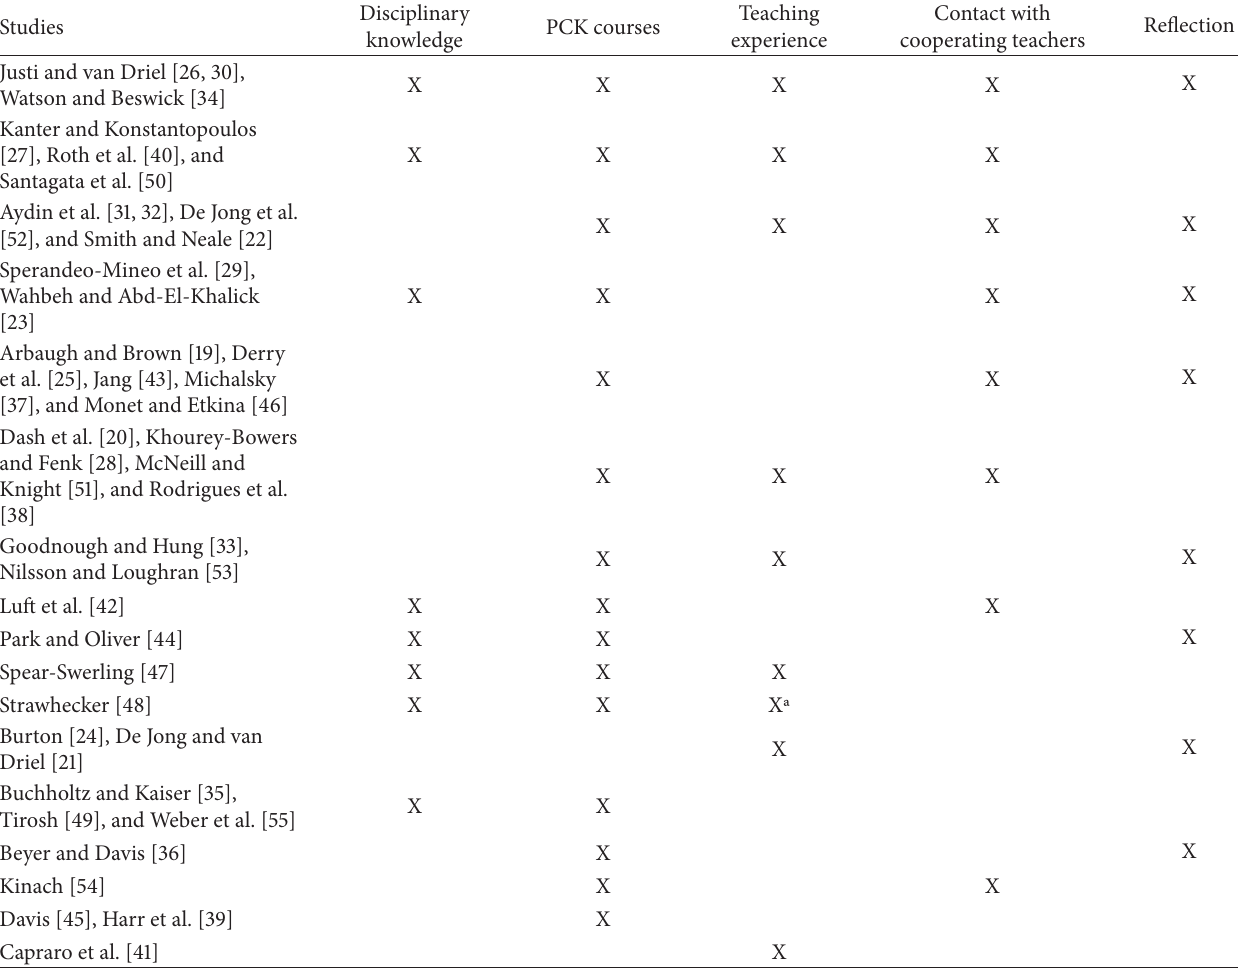
Table 3: Overview of the PCK sources that are focused on in the